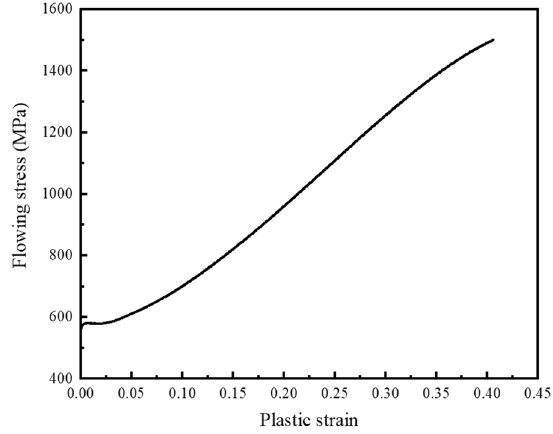
Figure 4 The hardening curve of SUS301L-MT